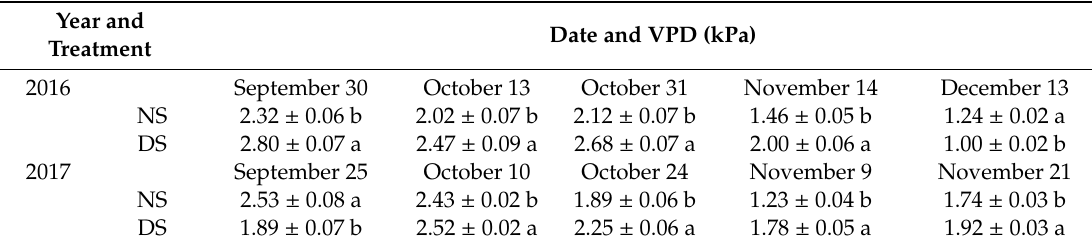
Table 2. Average vapor pressure di ff erence (VPD) values (kPa ± SE) during each sampling period in 2016 and 2017 between normal senescence (NS; ambient outdoor environment) and delayed senescence (DS; greenhouse) trees ( n = 40–44). For each date, di ff erent letters indicate significant di ff erences using Student’s least significant di ff erence mean separation test ( α =